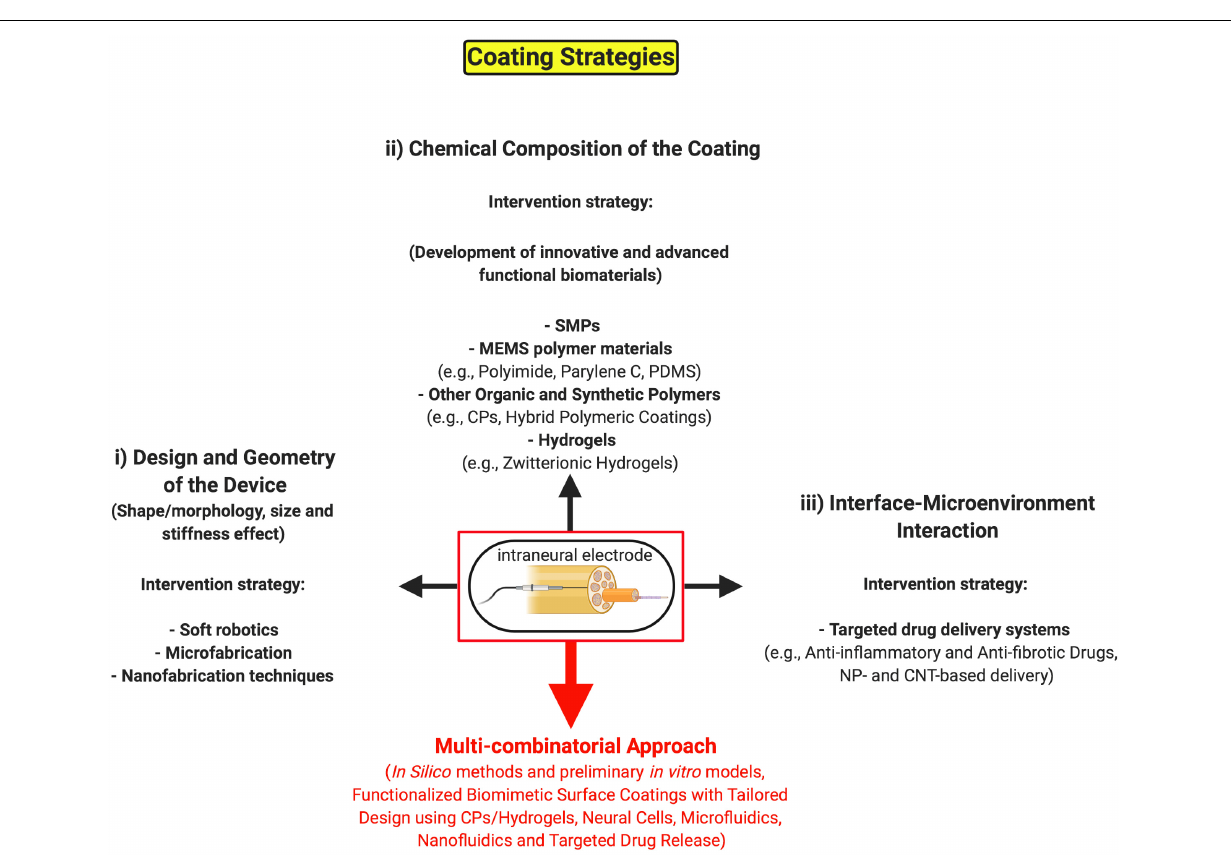
FIGURE 2 | Possible coating strategies of invasive neural implants to minimize the long-term FBR. Schematic representation of the main tissue engineering strategies for coating intraneural electrodes against the FBR: (i) the long-term stability and performance of invasive interfaces can be enhanced through the manipulation of the electrode shape, size, geometry, flexibility and surface roughness to create minimally invasive neural implants by leveraging on micro- and nano-manufacturing methods. (ii) An alternative intervention strategy consists in the development of novel chemical coatings, making use of advanced functional biomaterials, as biocompatible surfaces. (iii) Lastly, the functionalization of the coating with therapeutic drugs and, accordingly, innovative drug-delivery systems may help better integrate and tolerate the invasive device by the host nervous tissue. All of the above intervention strategies could be hopefully integrated into a unique multi-combinatorial approach (red arrow) in the next future. SMPs, shape memory polymers; MEMS, micro-electro-mechanical systems; PDMS, poly(dimethylsiloxane); CPs, conductive polymers; NP, nanoparticle; CNT, carbon nanotube. Created with